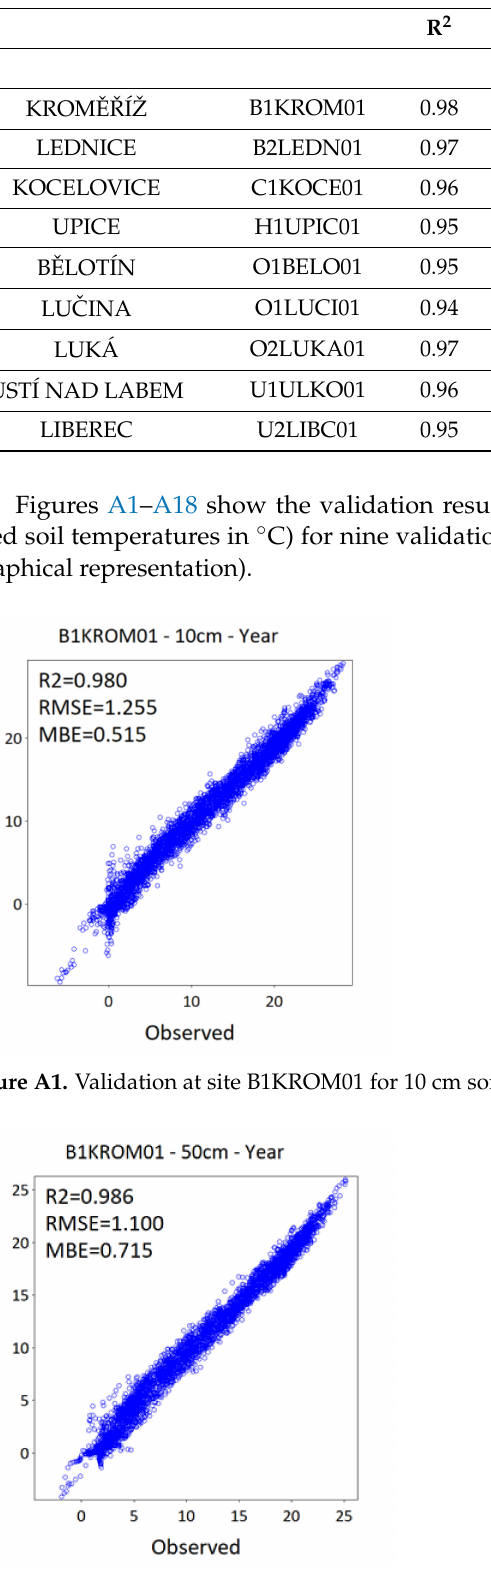
Figure A2. Validation at site B1KROM01 for 50 cm soil